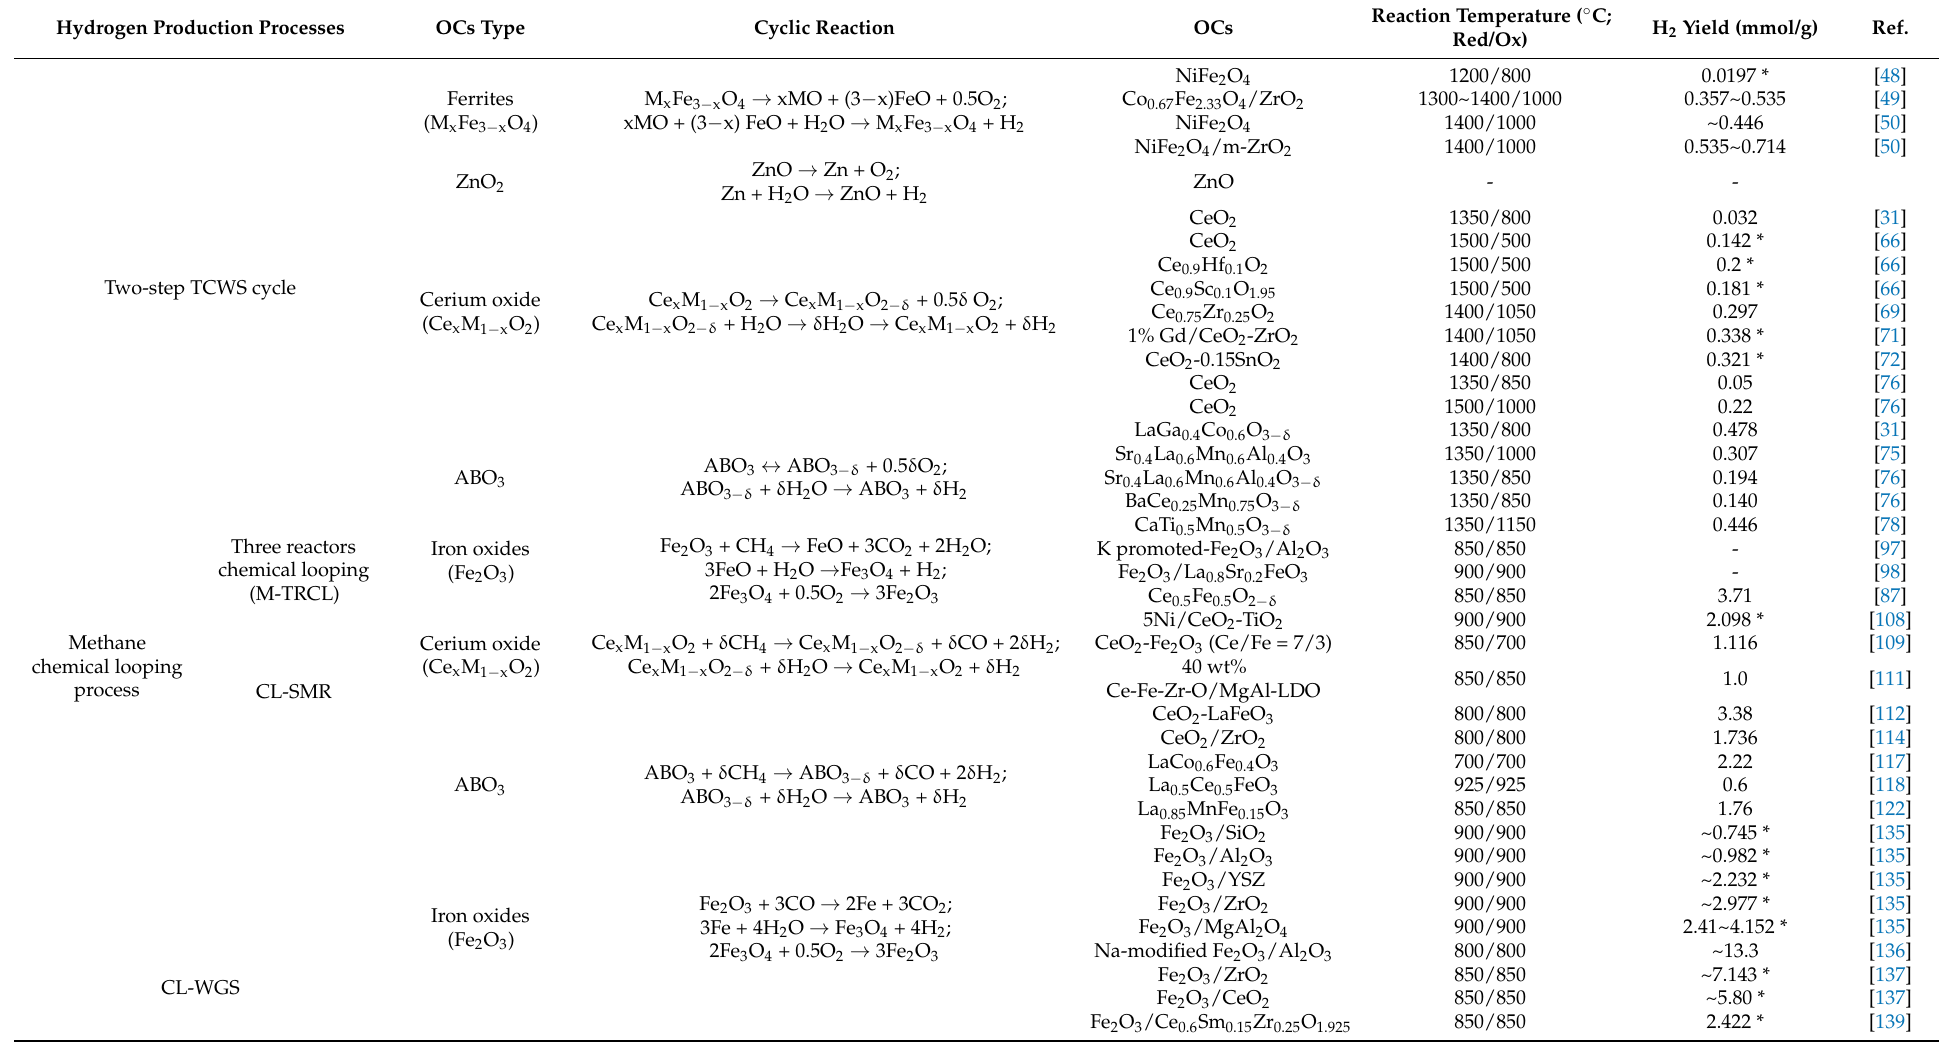
Table 1. Performance summary of OCs in different processes in